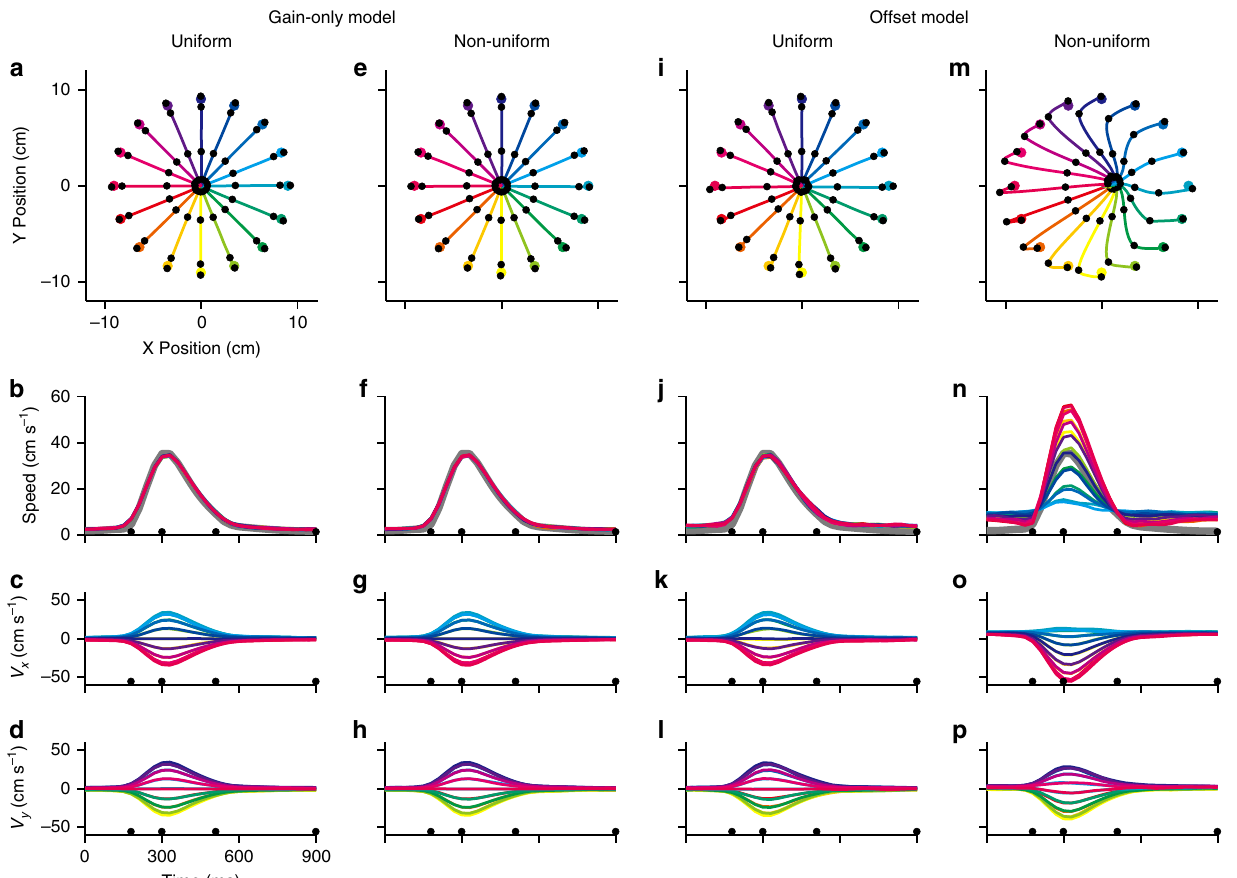
Fig. 5 Population decoding. Population decoding (using minimal OLE) in four simulated conditions: uniform ( a – d ) and non-uniform ( e – h ) distribution of preferred directions using the gain-only model, and uniform ( i – l ) and non-uniform ( m – p ) distribution of preferred directions with the offset model. a , e , i , m reconstructed trajectories for the 16 targets. b , f , j , n reconstructed speed pro fi les. The thick gray line represents the original speed pro fi le (which also applies to subsequent fi gures). The decoded velocity components, V x and V y , are shown respectively in c , g , k , o ; d , h , l ,